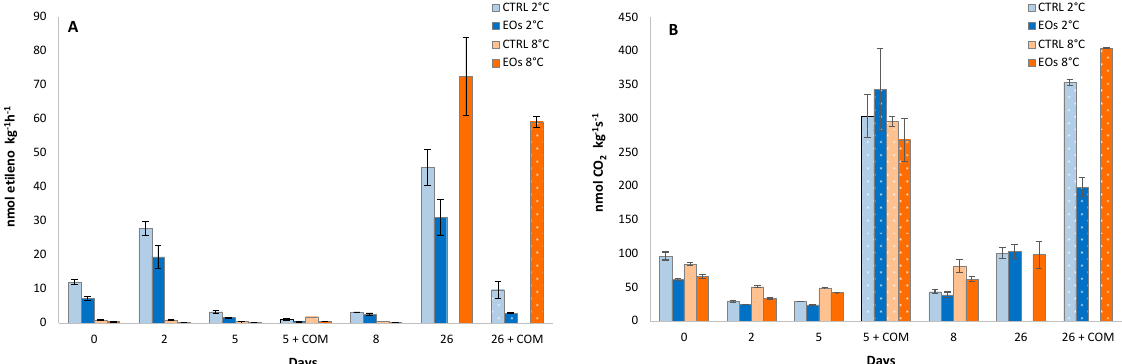
Figure 10. Ethylene production ( A ) and CO 2 production ( B ) throughout refrigerated storage periods (2 and 8 °C) and complimentary commercialization simulations ( COM ; 4 days at 22 °C) of flat peach with or without active paper sheets (including encapsulated EOS) (mean ± SD) [43]. Reductions of respiration and ethylene production rates of flat peaches and broccoli using active packaging including EOs achieved up to 30–50% and inhibiting the activities of key enzymes participating in the respiration pathways [43,44]. Figure 11 represents the heat production (calculated by the heat produced from respiration) and ethylene production rates during storage at 8 ◦ C of flat peaches within active packages. As observed, the reduction of ethylene production rates of 1.0 → 0.3 and 0.5 → 0.3 nmol kg − 1 h − 1 would imply a reduction of heat production from flat peaches of 33 and 14% after 2 and 5 days of storage at 8 ◦ C, respectively (Figure